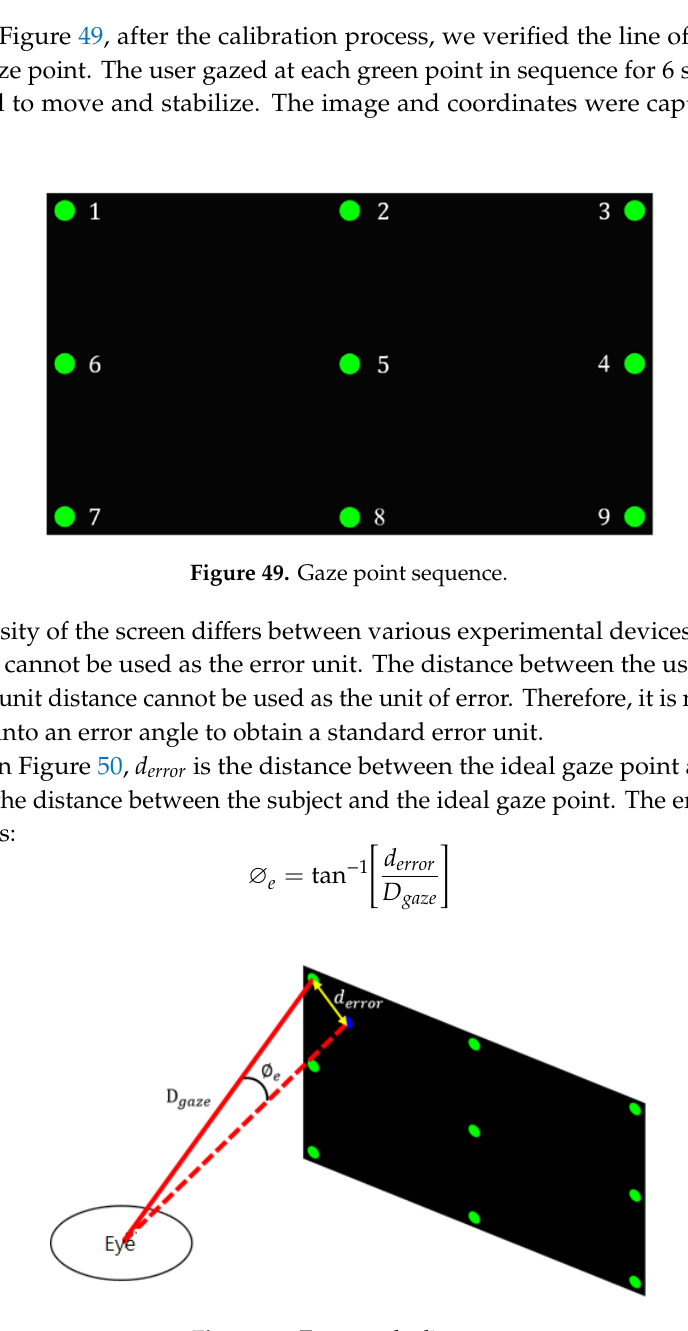
Figure 50. Error angle diagram.